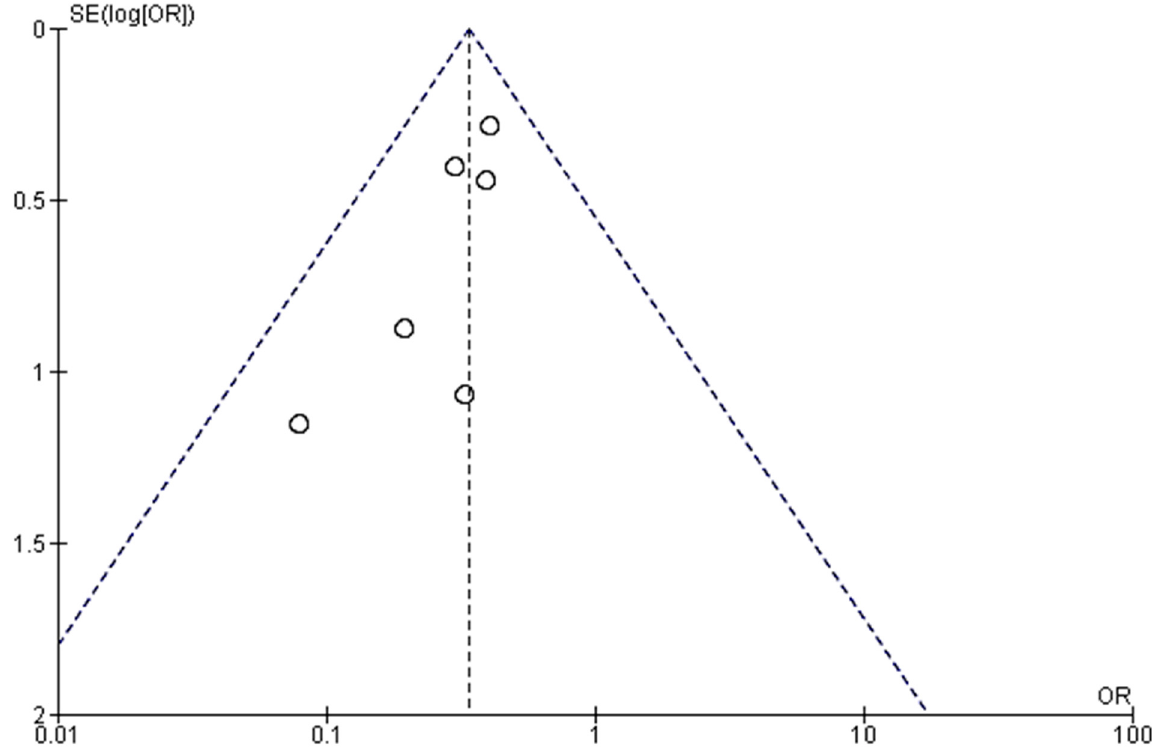
Figure 10. Funnel plot for the PPCs incidences reported by the studies.